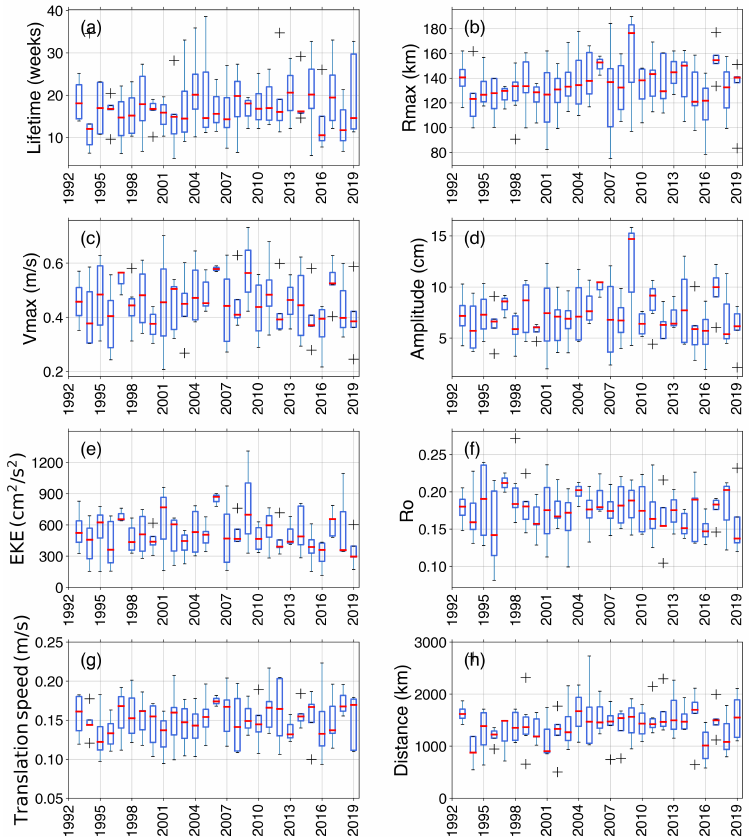
Figure 11. Inter-annual variability of the NBC rings physical parameters during the 27 years of ADT fields. ( a ) Lifetime, ( b ) Radius max ( c ) Velocity max, ( d ) Rossby number, ( e ) Kinetic energy, ( f ) Amplitude, ( g ) Translation speed, ( h ) Distance covered. The box extends from the first to third quartile values, with a red line at the median. The whiskers extend from the edges of the box to show the extreme data points, and black crosses are